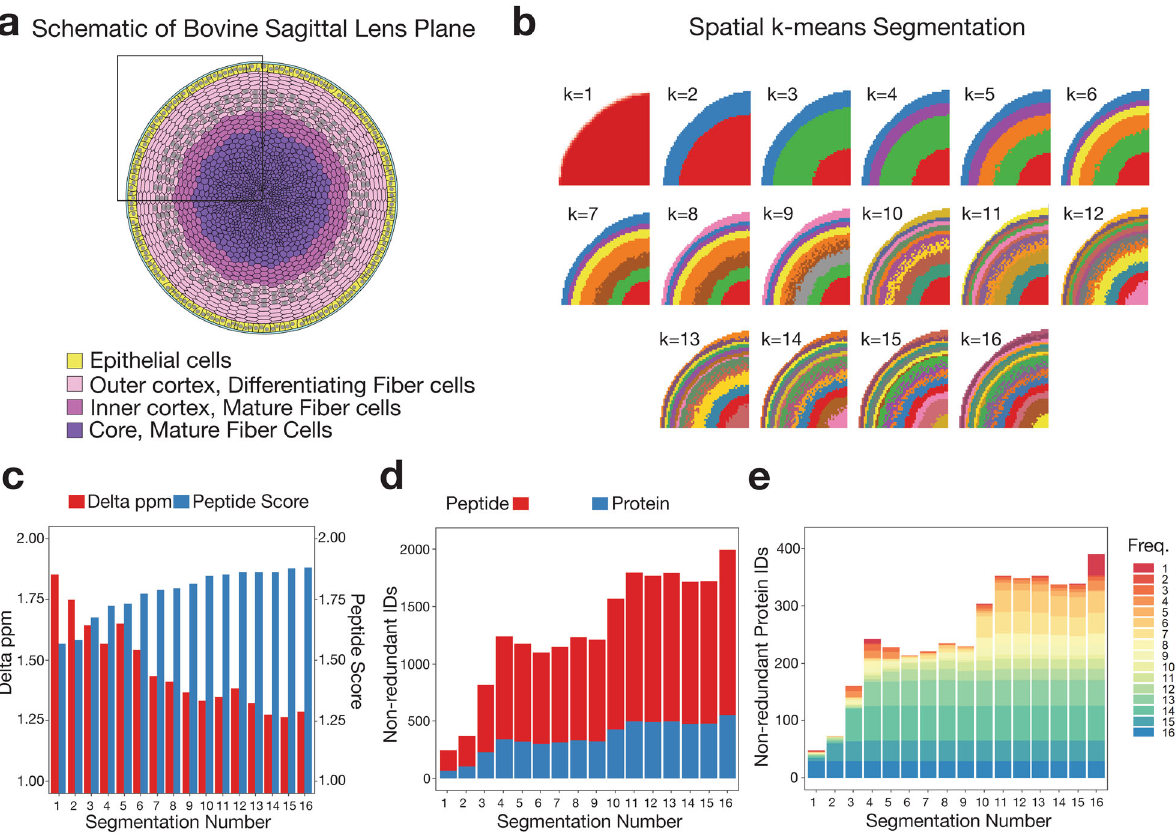
Fig. 4 Optimisation of segmentation analysis. a Diagrammatic representation of the sagittal plane of the bovine lens detailing the 4 major anatomical regions. b HIT-MAP spatial k -means clustering of a MALDI – MSI lens dataset based on speci fi cation of between k = 1 − 16 data-driven segments (colours show individual segments). Note the unbiased annular segmentation in line with lens anatomy. c The median mass variance in exact mass- fi ltering of candidate peptides against m / z features within the experimental mass spectrum, and the subsequent median peptide score of m / z features shows improved peptide scoring and declining ppm error during exact mass fi ltering with increased segmentation. d The total number of non-redundant peptide and protein identi fi cations by HIT-MAP with varying segmentation of the lens, and e the total number of non-redundant protein identi fi cations by HIT-MAP with varying segmentation of the lens — protein IDs are grouped and coloured by their identi fi cation frequency across the serial segmentation